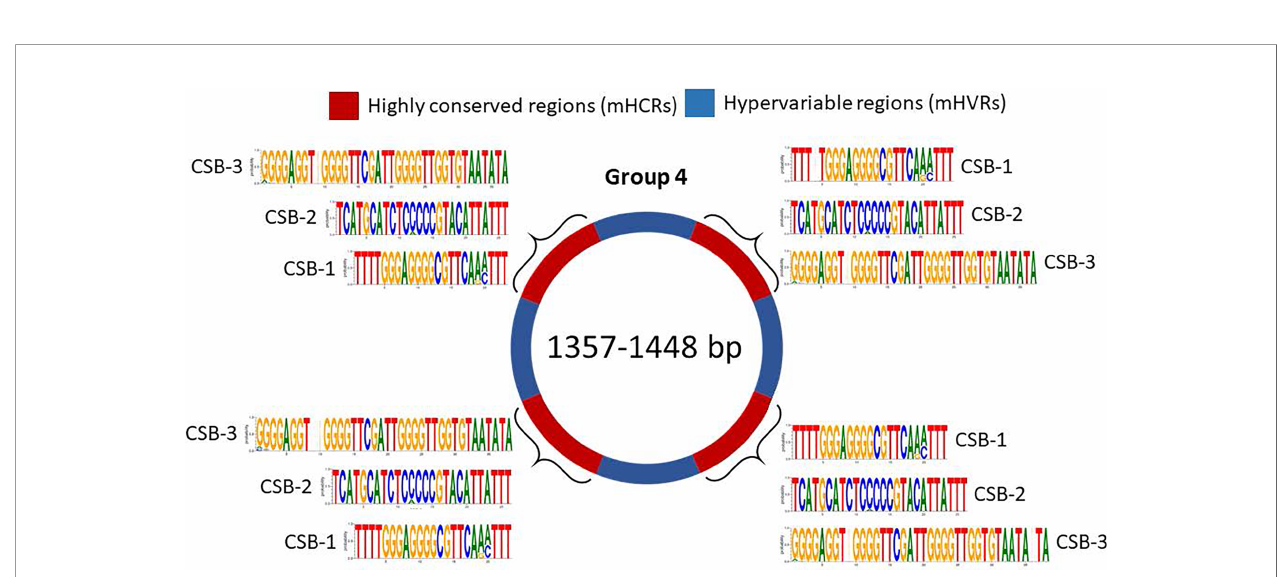
FIGURE 6 | Sequence structure of minicircles from group 4 (1357-1448 bp). mHCRs are shown in red and mHVRs in blue. Logos of each CSB region are displayed in each